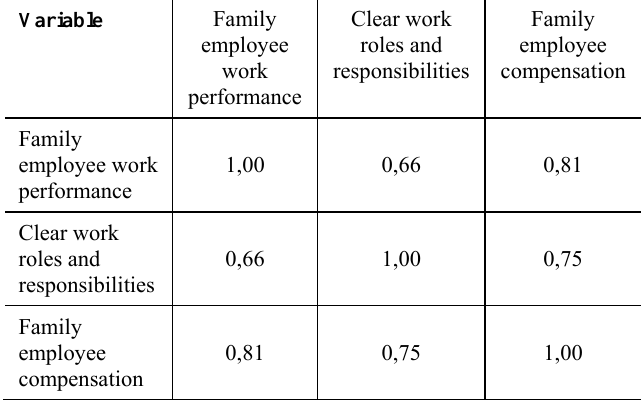
Table 4: Correlation between